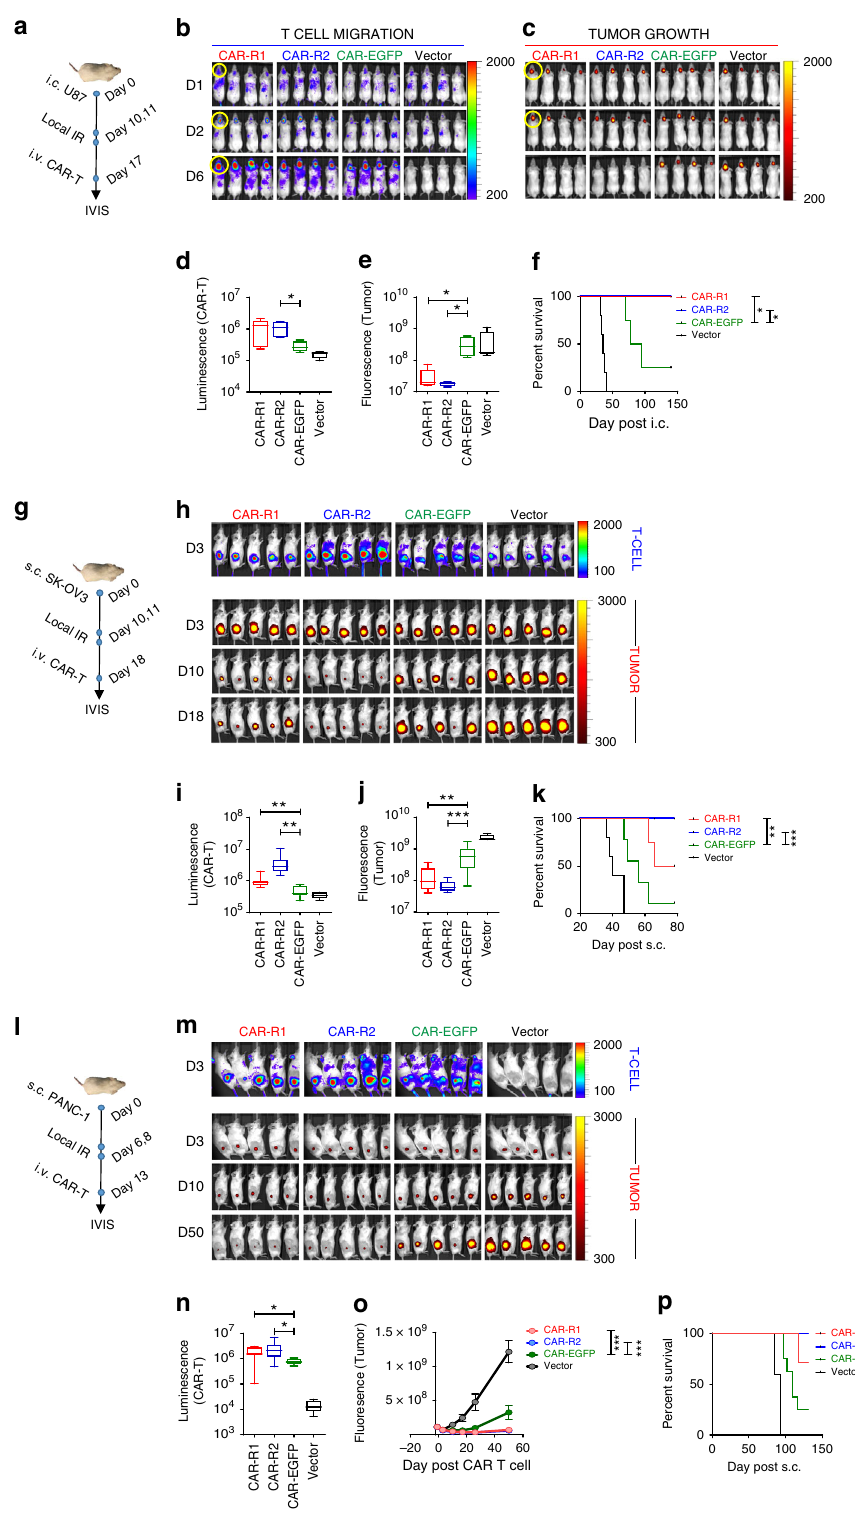
(Fig. 6h). To further evaluate the long-term protection by disease characterized by progressing tumors (Fig. 6k). A 8R70CAR T cells, the cured mice were rechallenged in the remarkable surge of the CAR-R1 or CAR-R2 T cells was observed opposite hemisphere with U87.i720 (on day 77 after the fi rst after tumor injection in rechallenged sites (Fig. 6l), which pre- tumor i.c. inoculation) (Fig. 6i, j). While the rechallenged mice cipitated long-term survival bene fi ts (Fig. 6m). Thus, the new grew tumors that regressed completely in the CAR-R1 or CAR- CAR design equips T cells with better antitumor reactivity and R2-treated groups, all the tumor-only mice succumbed to their immunologic memory for long-lasting tumor control. NATURE COMMUNICATIONS| (2019) 10:4016